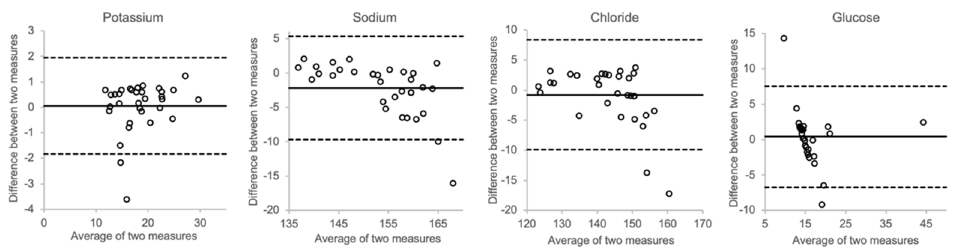
Figure 8. Comparison of actual concentration and calculated concentration (vitreous + spike).